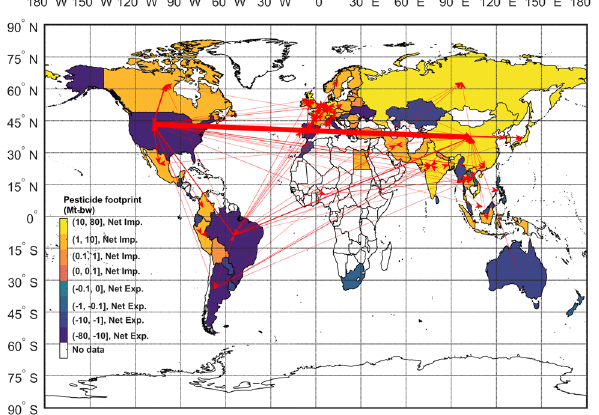
Fig. 4 Top 100 international fl ows of embodied pesticide footprints between countries of fi nal sale and countries of consumption. Red lines represent the fl ows with the fl ow volume proportional to the line thickness (the thicker the line, the larger the fl ow volume). The colour map represents the footprint embodied in imports minus the footprint embodied in exports on a scale from − 80 to 80 megatonnes of body weight (Mt-bw). Net imp. refers to net importer and Net exp. refers to net